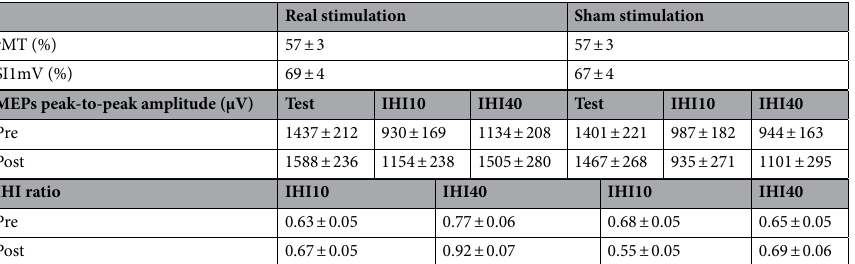
Table 2. The summary of results in Experimental 2. Data are shown as mean ± SEM. rMT resting motor threshold, MEPs motor evoked potentials, SI1mV intensity to obtain a 1 mV MEPS peak-to-peak amplitude, IHI interhemispheric